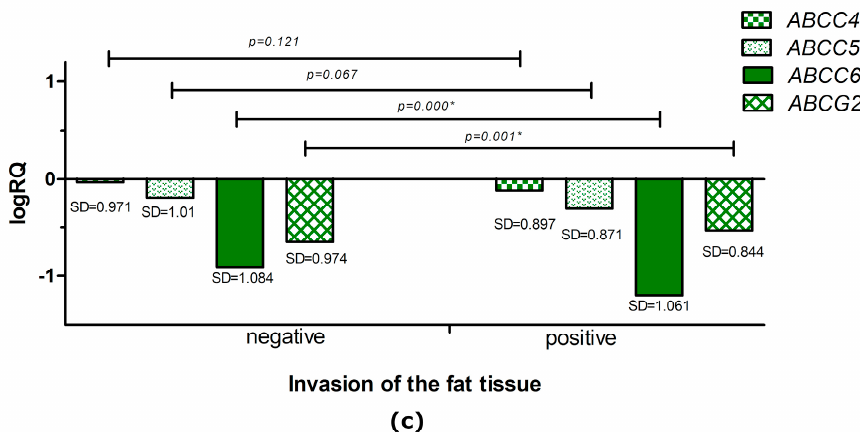
Figure 5. Mean expression level (logRQ) of the ABCA2 , ABCA3 , ABCB1 , ABCB4 , and ABCB9 genes ( a ); the ABCC10 , ABCC11 , ABCC1 , ABCC2 , and ABCC3 genes ( b ); and the ABCC4 , ABCC5 , ABCC6 , and ABCG2 genes ( c ) in triple-negative breast cancer tissue compared to tissue normal in groups based on the presence or absence of cancer cells in fat tissue. * Significance level of the U Mann–Whitney test.